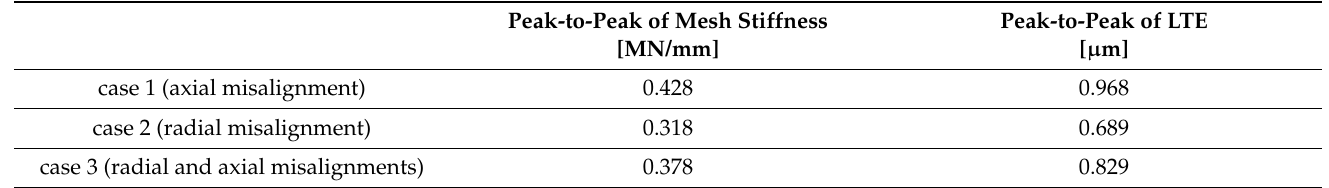
Table 1. The peak-to-peak amount of LTE and mesh stiffness.